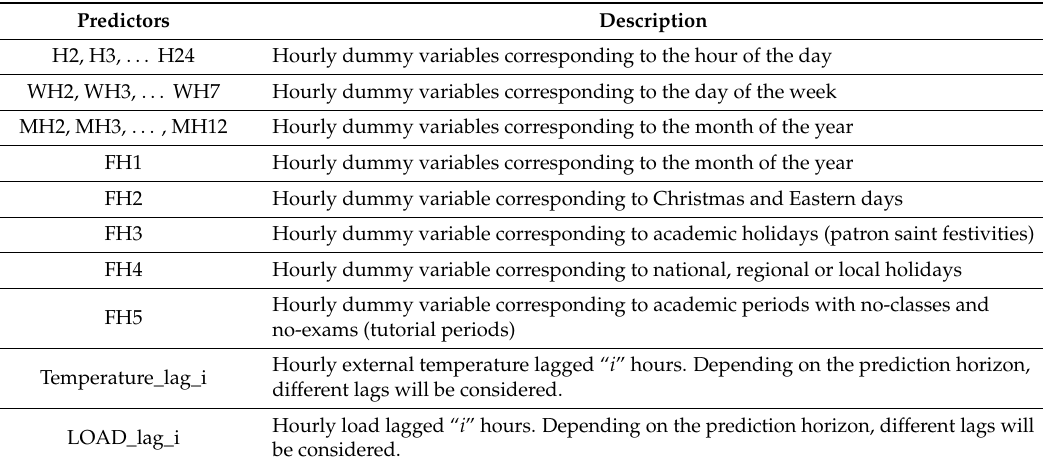
Table 2. Description of the